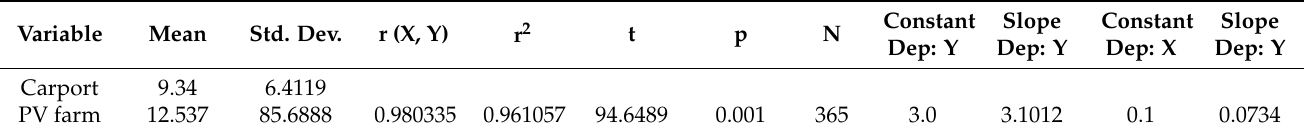
Table 2. Accurate results of the statistical analysis of the correlation of the PV Farm and carport variables.